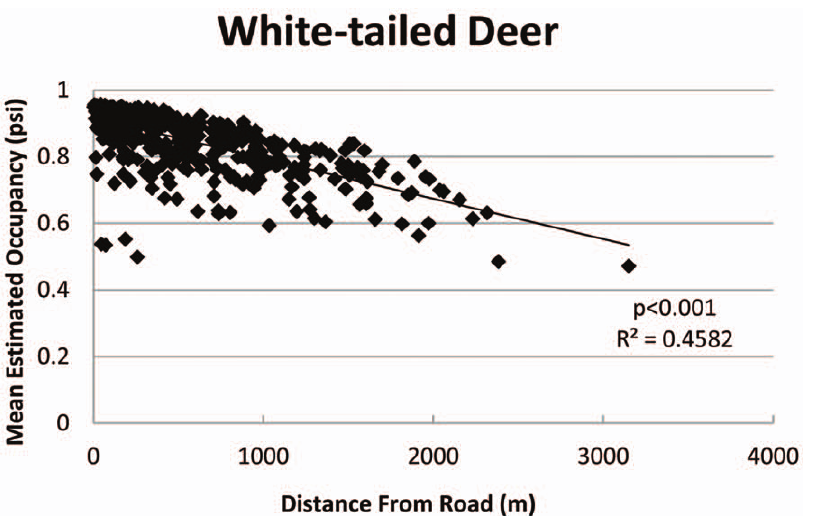
Figure 4. Estimated occupancy as a function of distance from road for white-tailed deer, the 2 species for which distance from road was present in the top models and received . 0.5 Akaike weight.